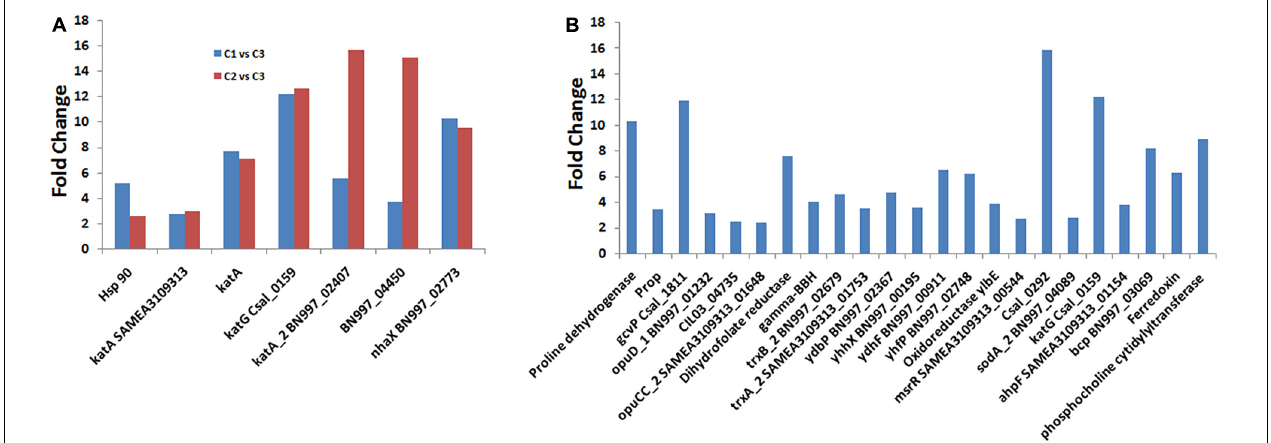
FIGURE 5 | Differentially expressed genes (DEGs) involved in adaption to osmotic and oxidative stress. (A) Represents the comparison of the fold change in some of the transcripts involved in salt stress between the C1 vs. C3 and C2 vs. C3, and (B) represents the fold change of the DEGs involved in osmotic and oxidative stress